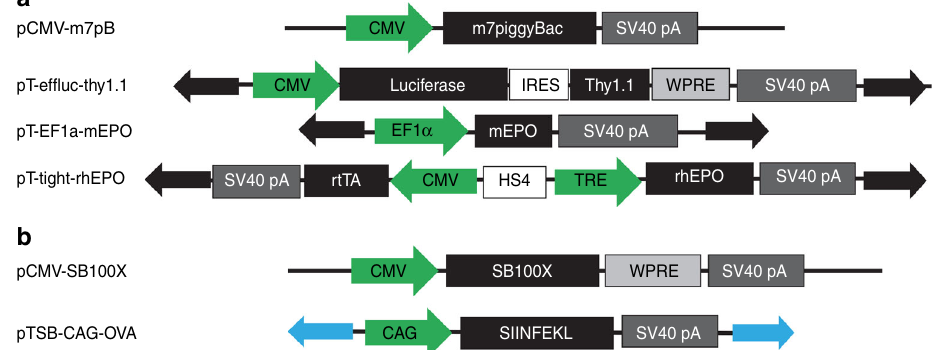
Fig. 1 Vector schematics. a The piggyBac transposase was used with the pT-Tight-hEPO, pT-EF1 α -mEPO, and pT-ef fl uc-Thy1.1 transposons. b The Sleeping Beauty transposase was used with the pTSB-CAG-OVA transposon. CMV, cytomegalovirus immediate early enhancer/promoter; piggyBac , transposase; pA, SV40 polyadenylation signal; HS4E, core insulator sequence from the chicken B-globin 5 ′ HS4 element; mEPO, recombinant murine erythropoietin cDNA; hEPO, recombinant human erythropietin cDNA; CAG, CAG synthetic promoter sequence; ef fl uc, enhanced fi re fl y luciferase; Thy1.1, mouse thy1.1 antigen; TRE, tetracycline response element; Tet-ON 3G, tetracycline transactivator; WPRE, woodchuck hepatitis post-transcriptional regulatory element; IRES, internal ribosomal entry site; SV40, simian virus 40 late polyadenylation signal. Solid arrows indicate inverted terminal repeat (ITR) sequences: black, piggyBac ITRs; blue, Sleeping Beauty